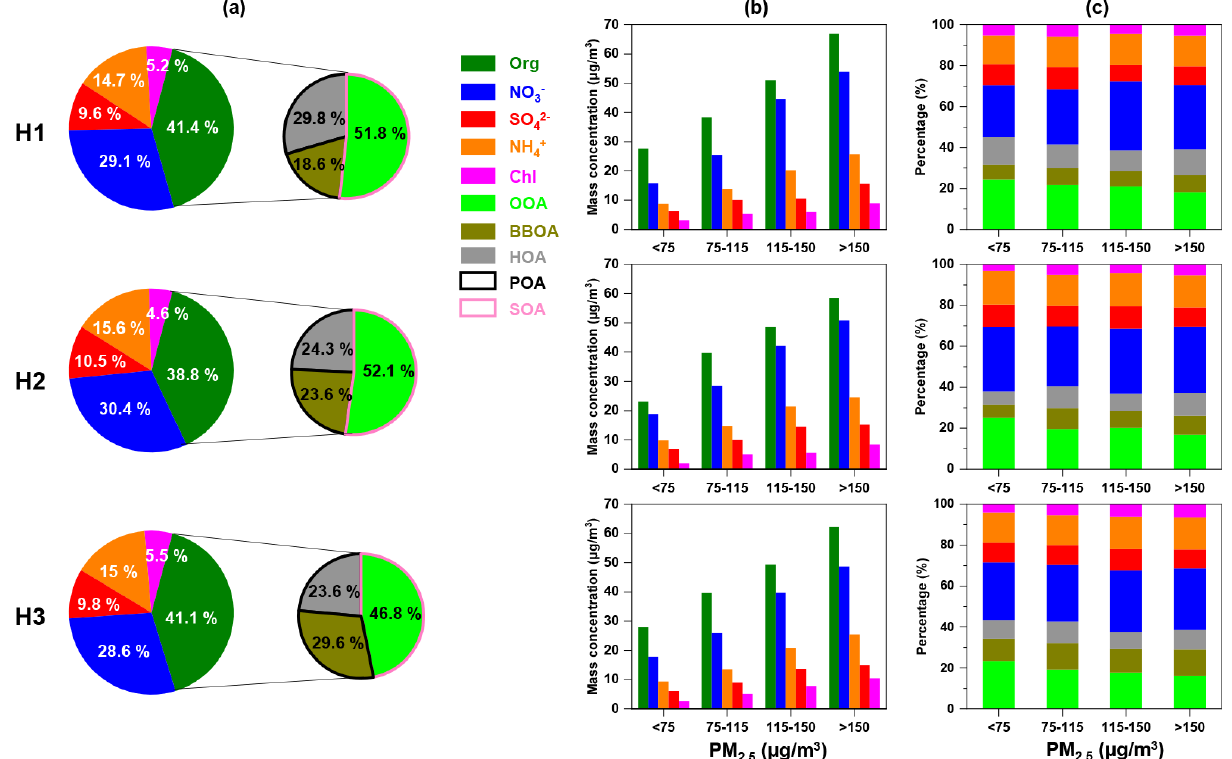
Figure 11. (a) Average mass fractions of different chemical compositions in PM 2 . 5 , (b) mass concentration and (c) relative contribution of inorganic/organic species as a function of PM 2 . 5 concentration during each haze episode. The right side of (a) depicts the contribution of OOA, BBOA and HOA to